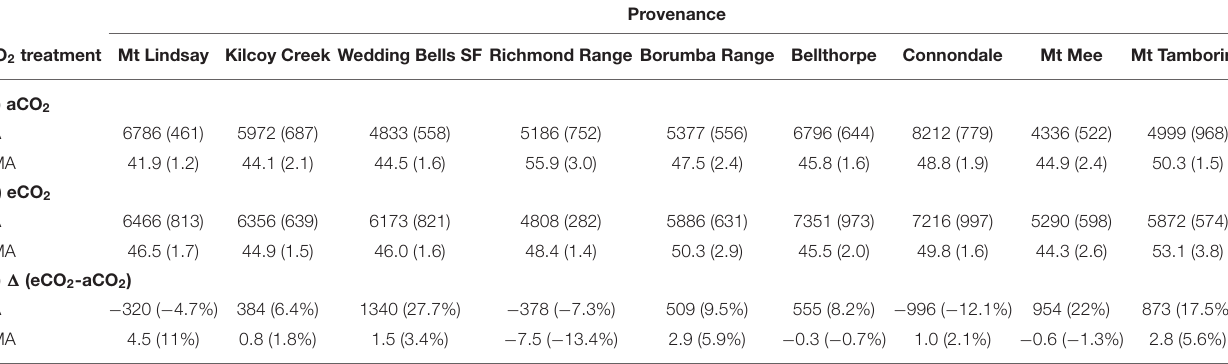
TABLE 4 | Leaf characteristics of E. grandis seedlings of Experiment 2 grown in ambient [aCO 2 ; (a)] and elevated [CO 2 ] [eCO 2 ; (b)].